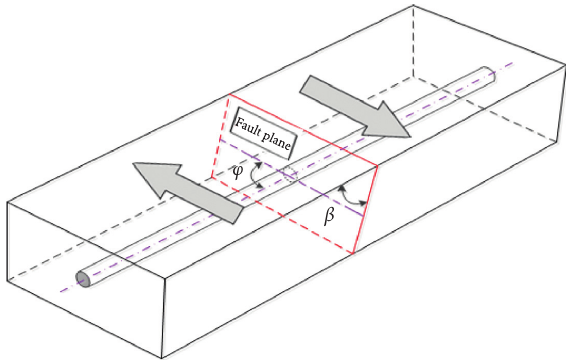
Figure 1: Geometric view of pipe crossing